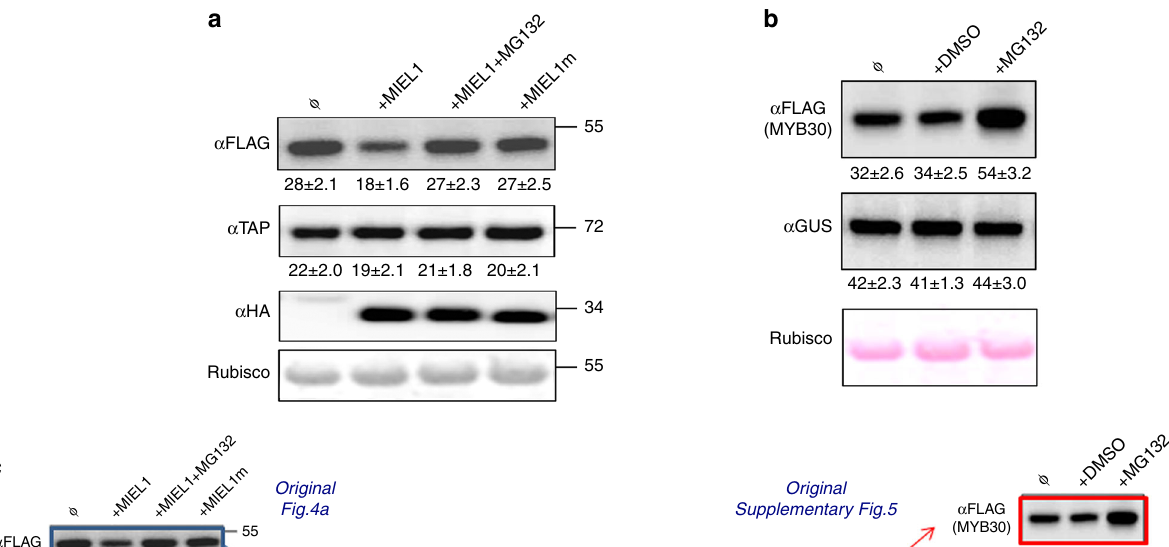
(b)54±3.2 Rubisco lanes used in updated versions of Fig.4a (green) and Supplementary Fig.5 (yellow) shown in panels (a) and Fig. 1 Updated version of Fig. 4a and Supplementary Fig. 5. a Updated version of Fig. 4a showing the correct Ponceau-stained loading controls. FLAG- tagged MYB30 or TAP-tagged MYB123 were expressed in N. benthamiana alone or with haemagglutinin (HA)-tagged MIEL1 or MIEL1m, and treated or not with the proteasome inhibitor MG132, as indicated. Western blot analysis shows the expression of FLAG-tagged MYB30, TAP-tagged MYB123 and HA- tagged MIEL1 proteins. Molecular mass markers in kilodaltons are indicated on the right. b Updated version of Supplementary Fig. 5 showing the correct Ponceau-stained loading controls. N. benthamiana leaves transiently expressing FLAG-tagged MYB30 or the control protein GUS were mock-treated with DMSO or treated with the proteasome inhibitor MG132, as indicated. Western blot analysis shows the expression of FLAG-tagged MYB30 or GUS proteins. c Original scans of Ponceau-stained membrane and corresponding anti-FLAG Western blot. The loading control panel for Fig. 4a in the original article incorrectly shows lanes 2 – 5 (counting from the left) rather than lanes 4 – 7. The loading control panel for Supplementary Fig. 5 incorrectly